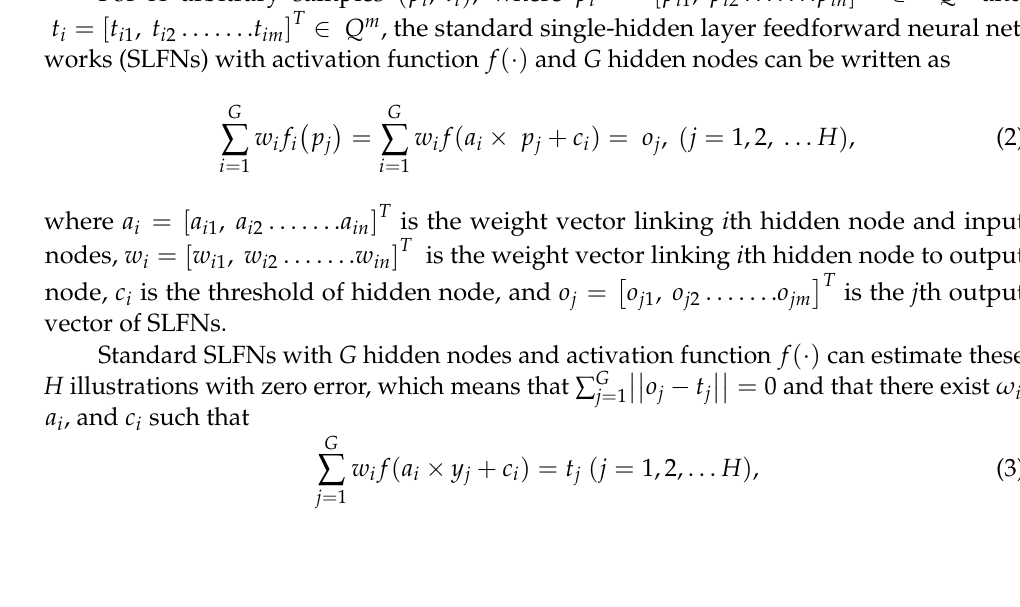
Figure 2. Extreme learning machine.